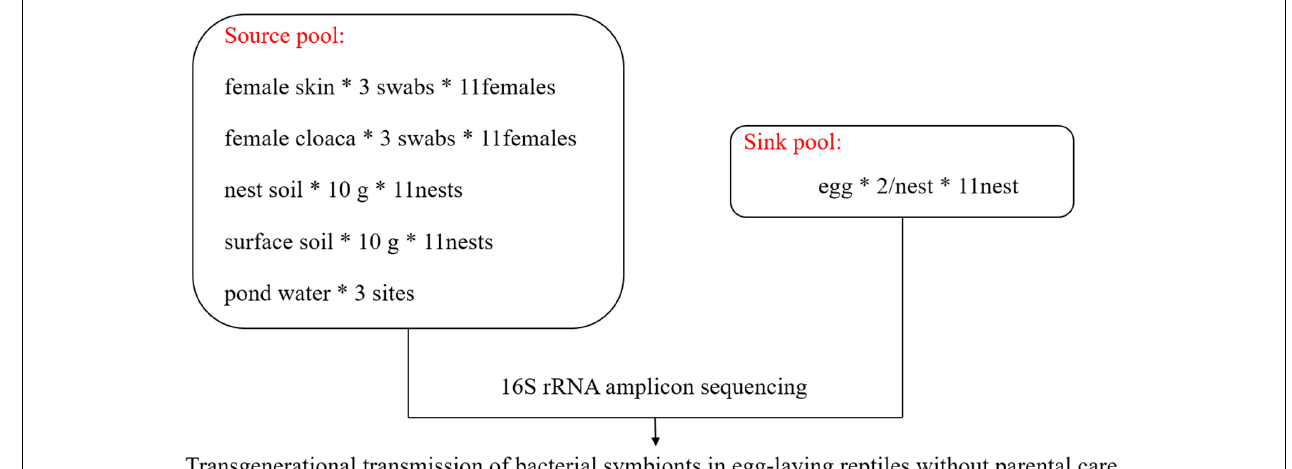
FIGURE 1 | Graphical scheme illustrating experimental design and sample collection. *Multiplication sign.